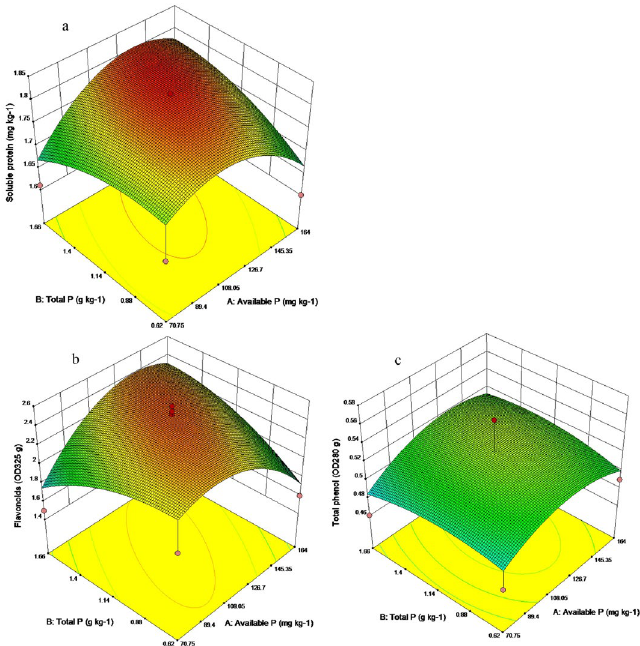
Figure 10. Response surface analysis of Chinese chives quality to soil nutrients. ( a ) Effect of interaction between the available P (X1) and total P (X2) content on the soluble sugar content (Y1). ( b ) Effect of interaction between the available P (X1) and total P (X2) content on the flavonoid content (Y2). ( c ) Effect of interaction between the available P (X1) and total P (X2) content on the total phenol content